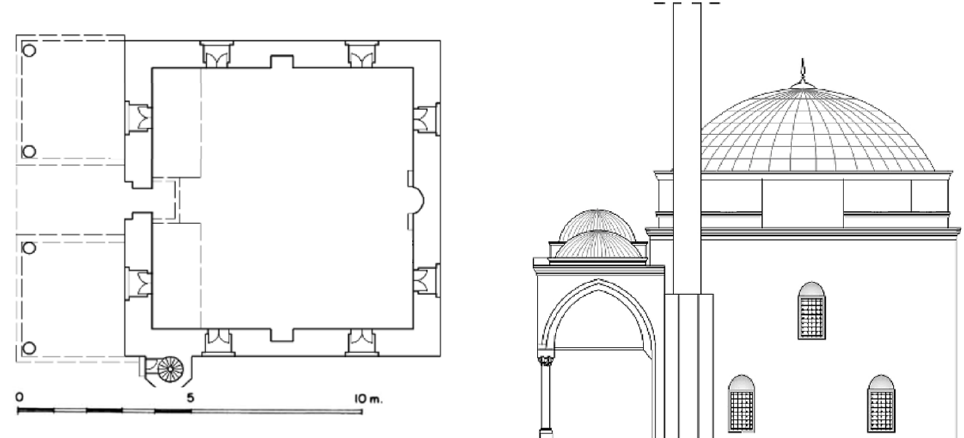
Figure 3. Plan layout ( left ) and elevation ( right ) of the Naziresha Mosque in Elbasan. Provision courtesy from Arch. Arsim Murseli, UBT University, Pristina, Kosovo.